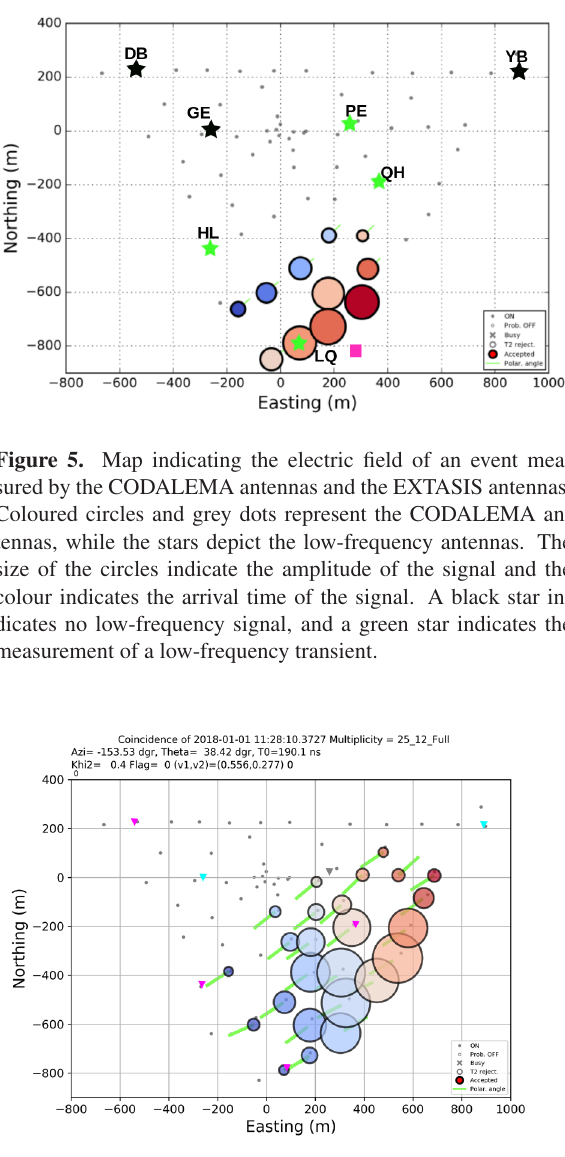
Figure 6. Map indicating the electric field of an event during a thunderstorm measured by the standalone antennas. The green lines indicate the polarisation of the signal. The arrival direction of the shower is almost parallel to the polarisation, which is not expected with the standard geomagnetic